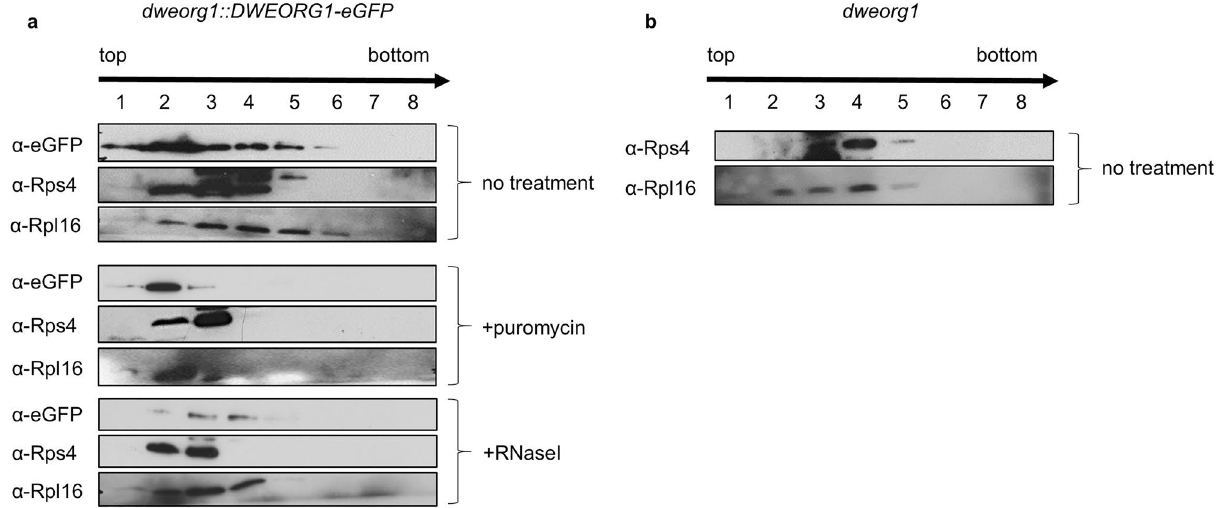
Figure 5. The DWEORG1 protein co-sediments with the Arabidopsis mitoribosome in a sucrose gradient. ( a ) Mitochondrial extracts prepared from root cultures of dweorg1 mutants complemented with a DWEORG1– eGFP construct were fractionated on 15%–55% sucrose gradients. An equal volume of each recovered fraction was analyzed via protein gel blot with the indicated antibodies (α-eGFP, α-Rps4 and α-Rpl16 detect proteins of 100 kDa, 40 kDa and 20 kDa, respectively); 1 refers to the top of the gradient and 8 to the bottom. The mitochondrial extracts were either not treated or treated with puromycin or RNaseI to destabilize